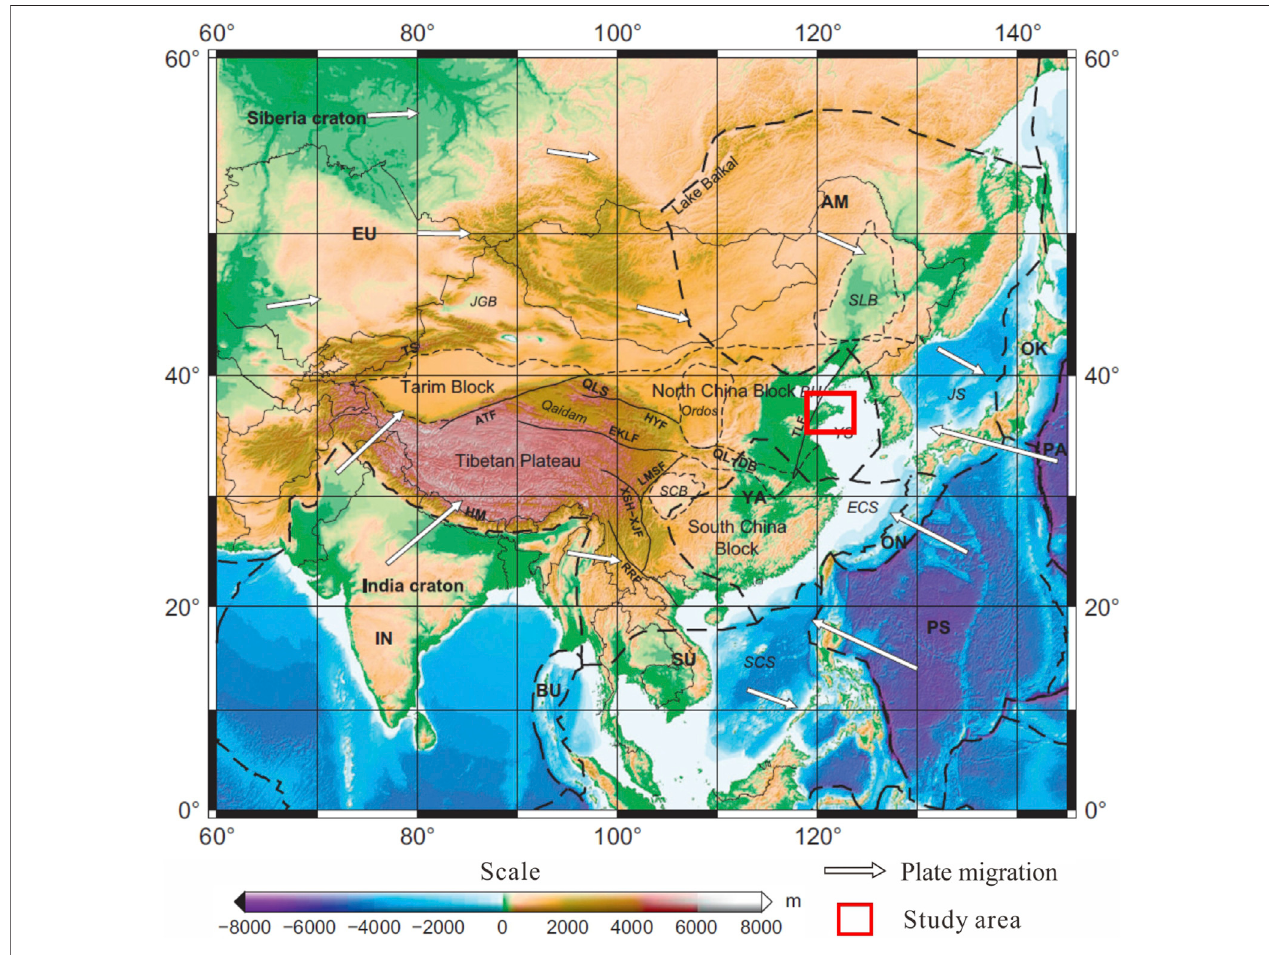
FIGURE 1 | Location of the Jiaodong Peninsula (modi fi ed from Chen et al., 2013).